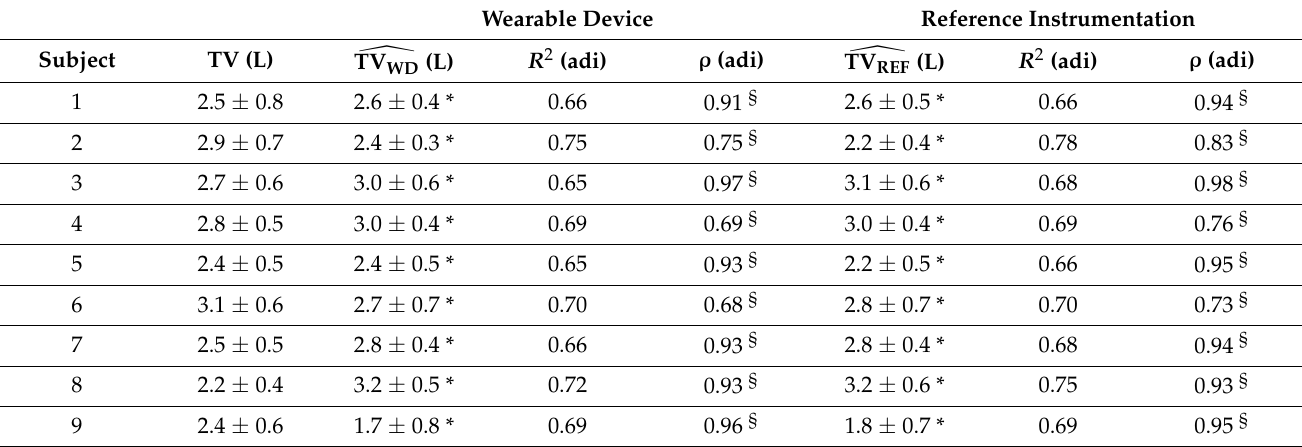
Table 5. Distribution estimations and gold standard of the